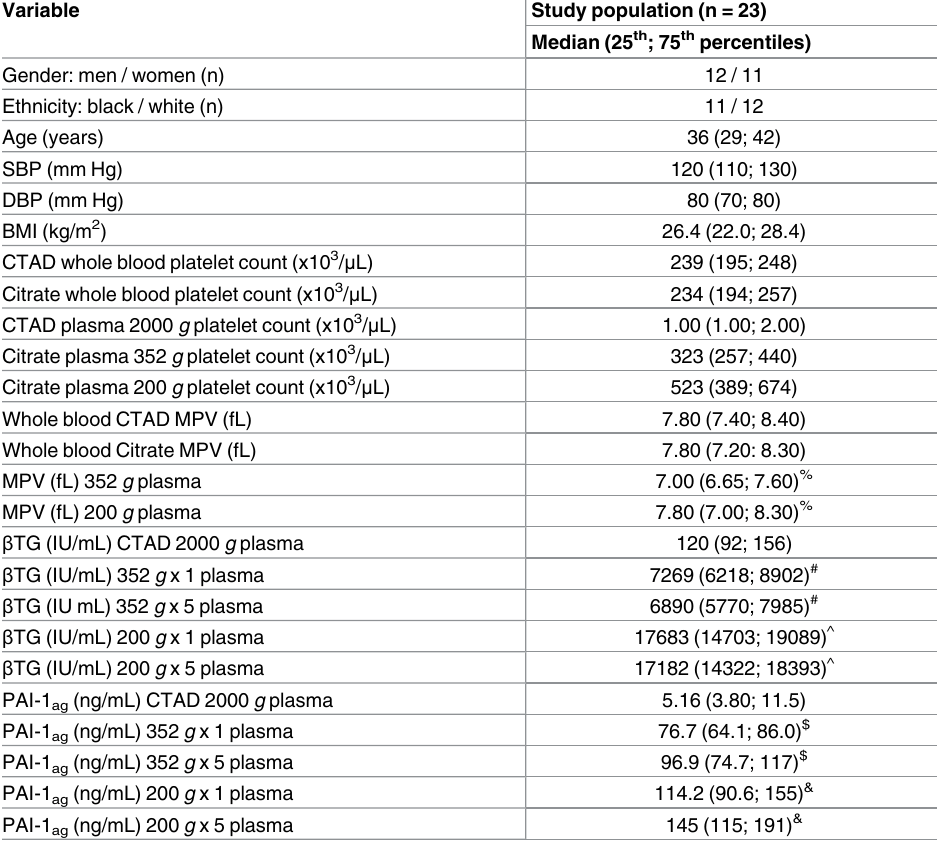
Table 4. Descriptive statistics of the follow-up study